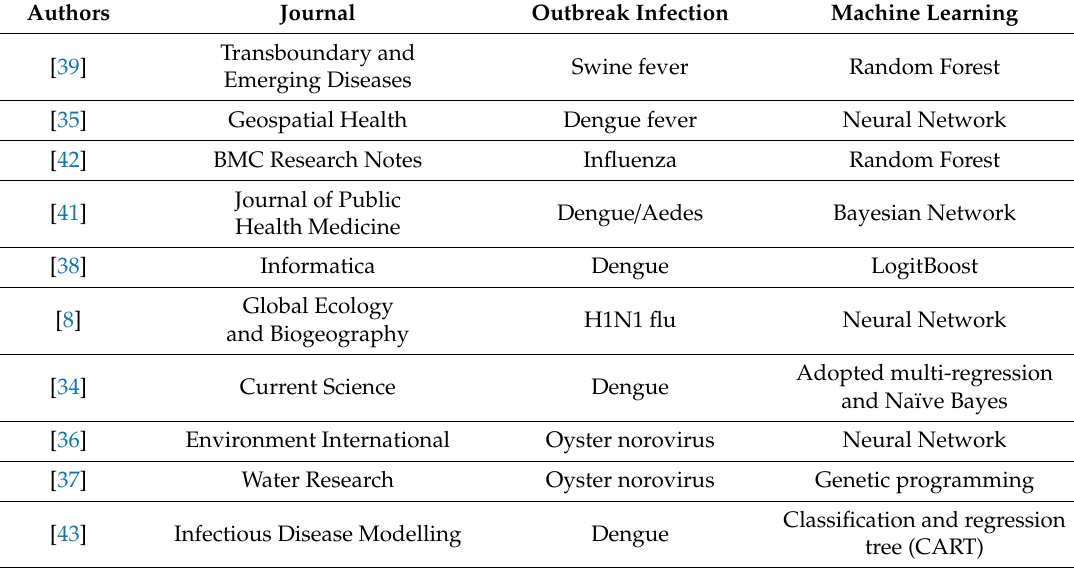
Table 1. Notable machine learning (ML) methods for outbreak